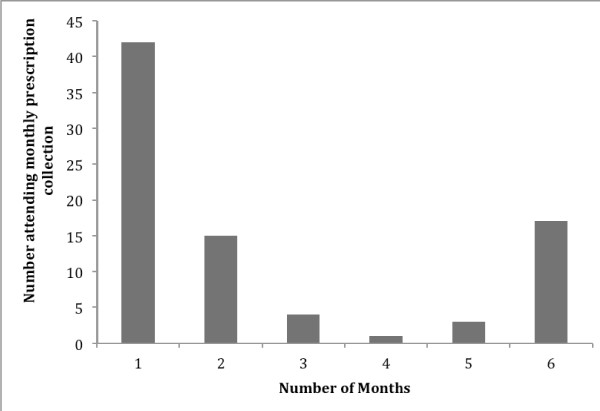
Distribution of number of months IPT prescription collected.